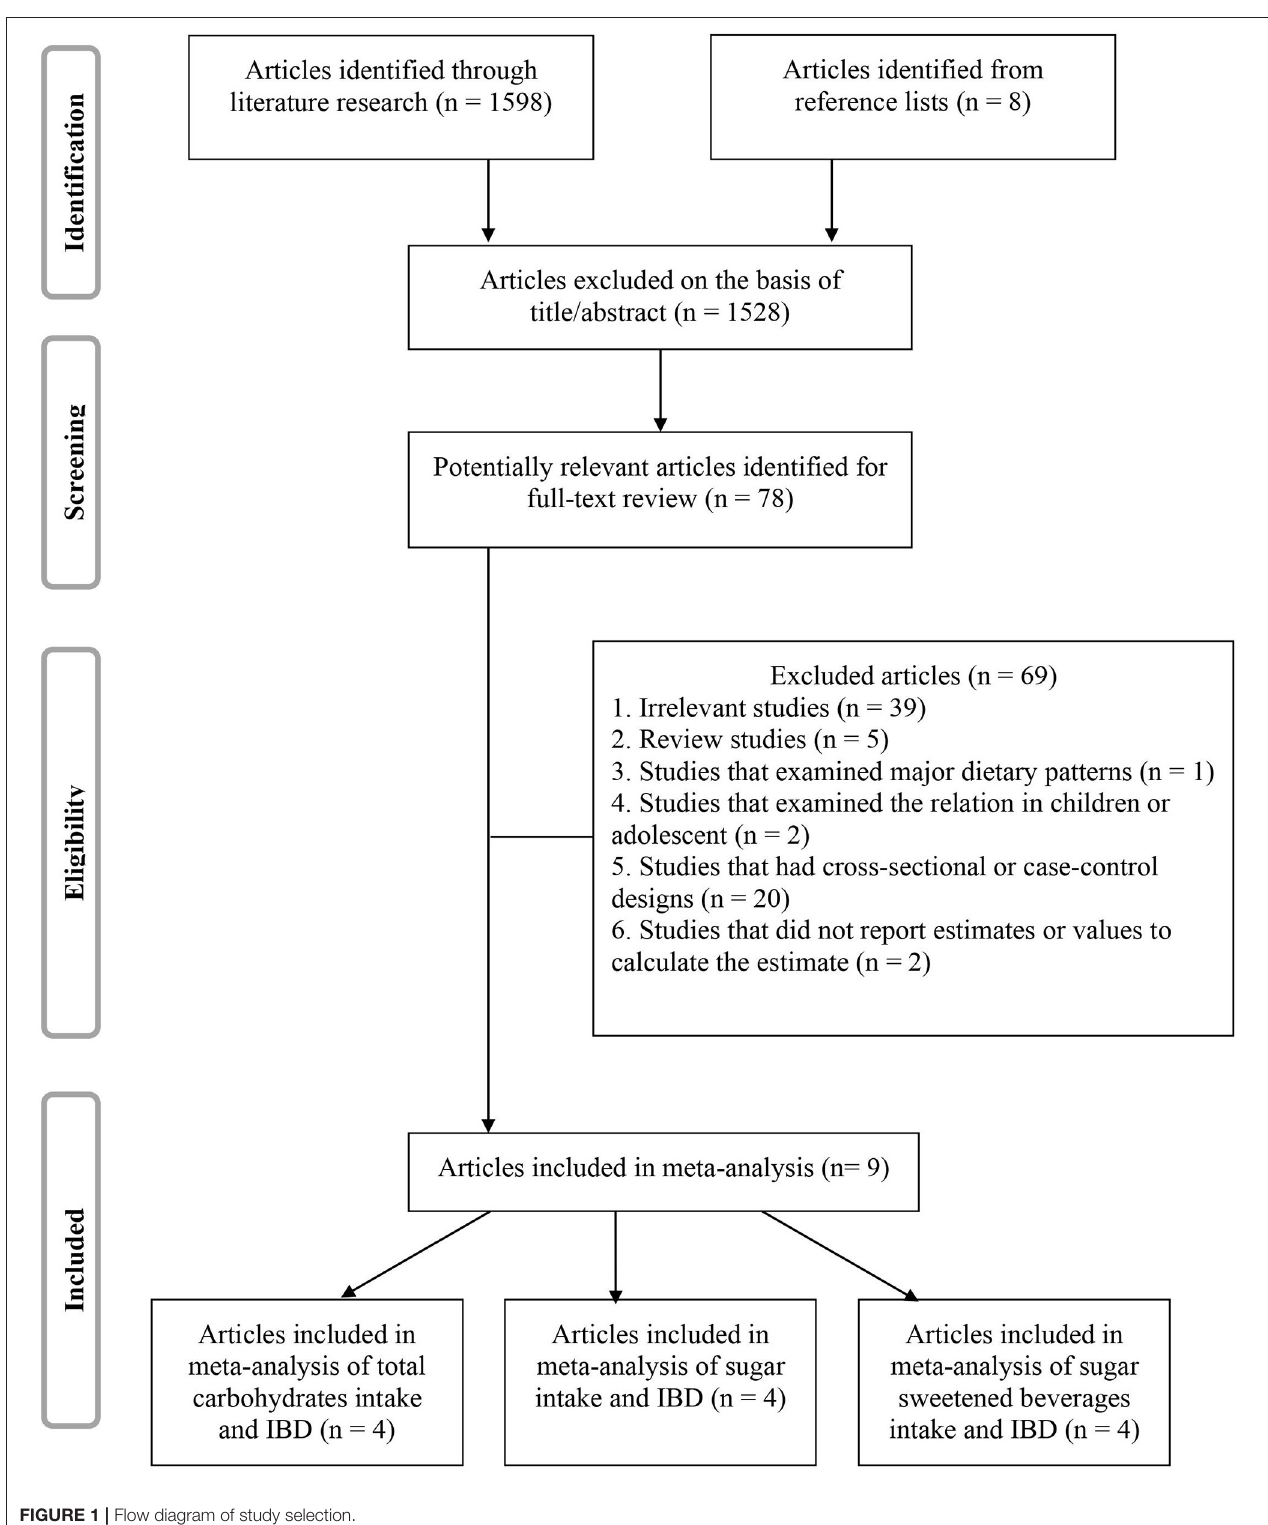
FIGURE 1 | Flow diagram of study